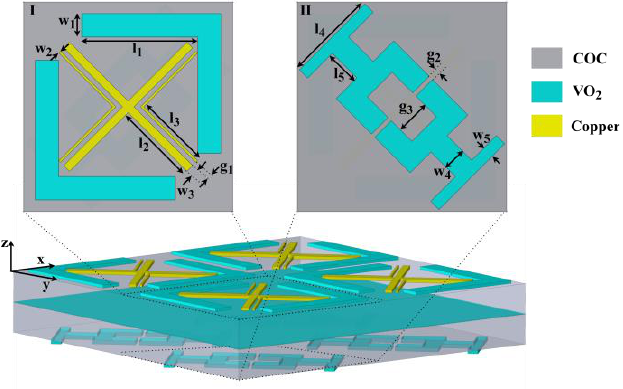
Figure 1. Unit structure and 2 × 2 periodic structure of metamaterials.